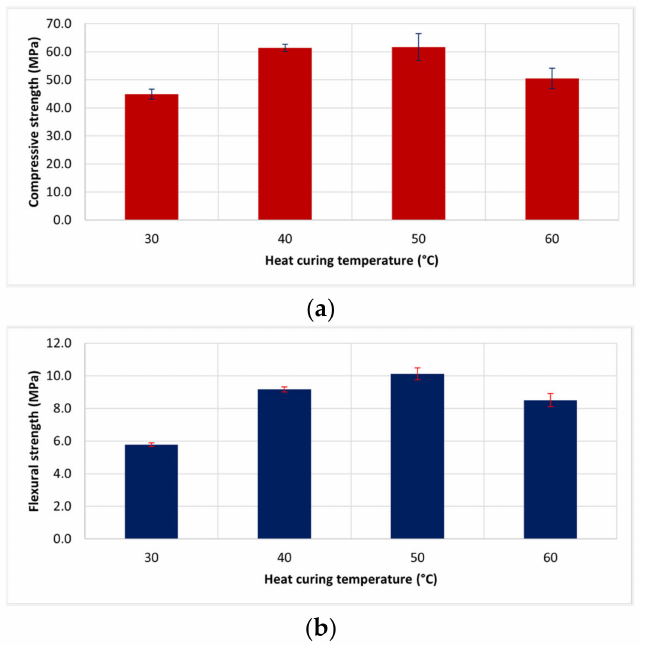
Figure 7. Effect of heat curing temperature on ( a ) compressive and ( b ) flexural strengths of W20GP at 28-day age with the solution of NaOH 8 M, SS/SH = 1.00, and L/B =